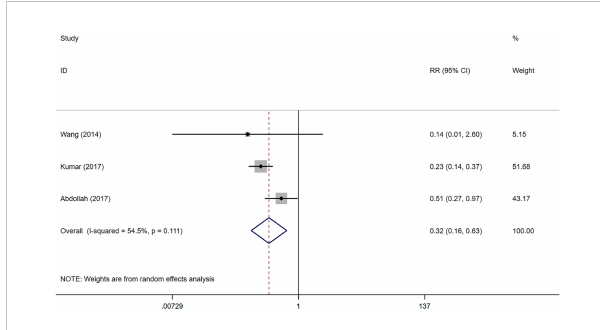
FIGURE 3 Forest plots of Erectile Function (12 month) for nerve sparing (NS) versus non-nerve sparing. CI, con fi dence interval; RR, Risk Ratio.